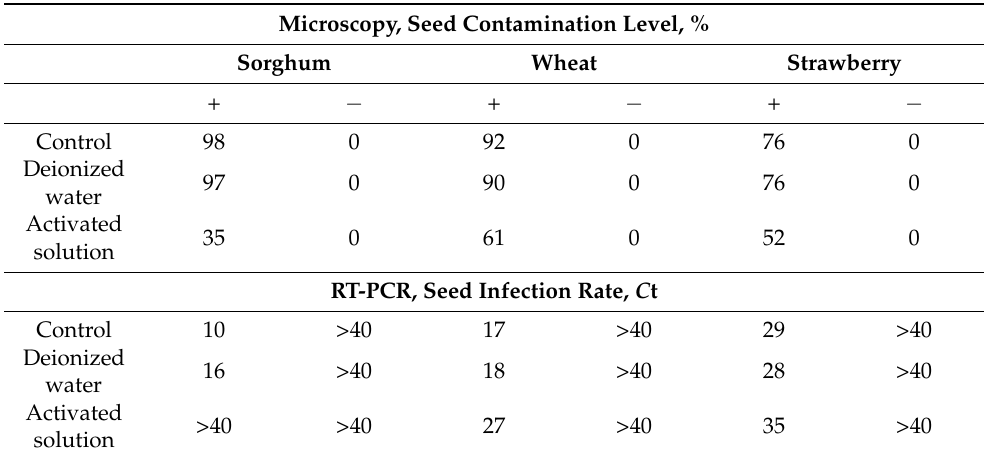
Table 2. Influence of aqueous solutions activated by glow discharge plasma on seed infestation with fusarium. Microscopy, Seed Contamination Level, % Sorghum Wheat Strawberry